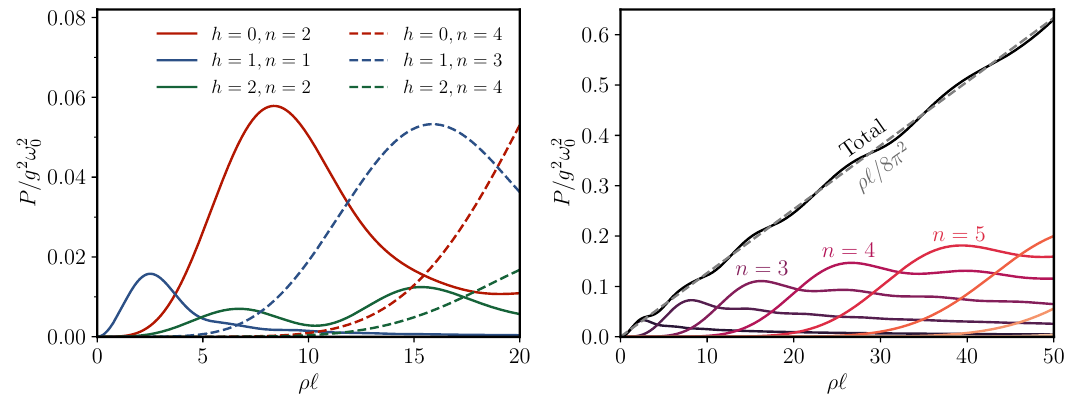
Figure 5 . Radiation from a particle with a scalar-like current in nonrelativistic sinusoidal motion of amplitude ‘ . The left panel shows the power emitted in each given harmonic and helicity, evaluated with (6.65). It does not show the ordinary, ρ -independent scalar radiation at h = 0 , n = 1 , as this is suppressed by v 2 . The right panel shows the power summed over helicities, evaluated using (6.69). 0 As discussed in the text, it implies the total power is well-behaved in the limit of low